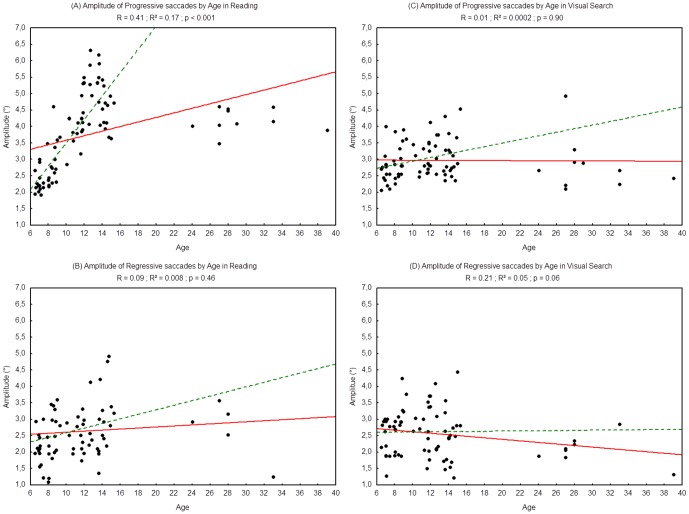
Amplitude of progressive saccades during reading (A), visual search (C) and amplitude of regressive saccades during reading (B) and visual search (D).Lines represent the corresponding regressions. Dotted lines represent the regressions for children only (from 6 to 15 years old), 2A: R2 = 0.65, p<0.0001; 2B: R2 = 0.04, p = 0.10; 2C: R2 = 0.08, p<0.02; 2D: R2 = 0.0001; p = 0.94.